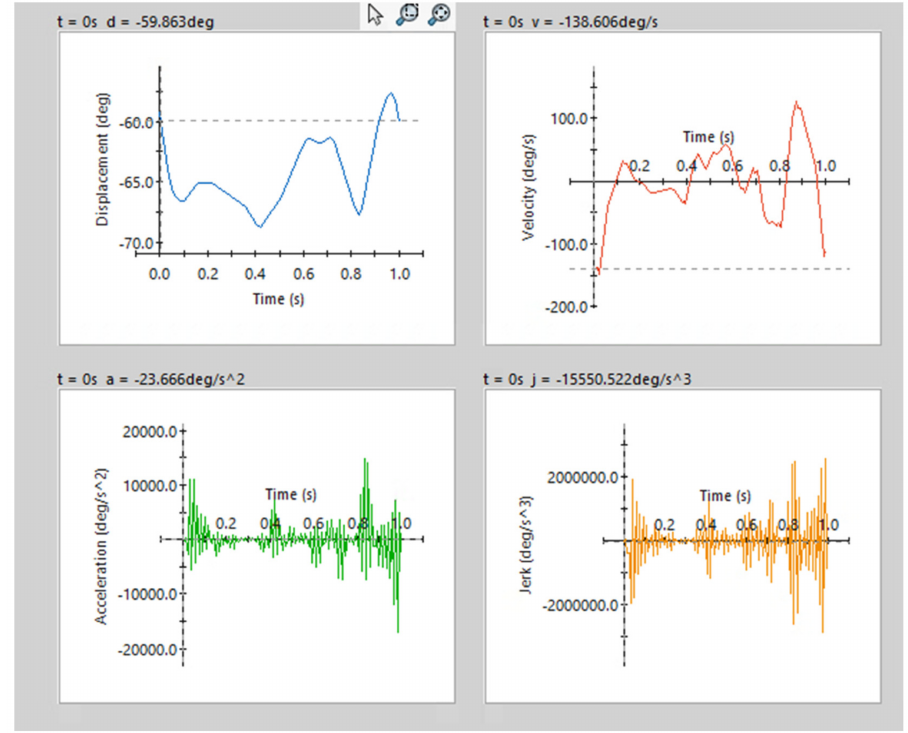
Figure 5. SolidWorks function builder used for angular displacement of the knee for crouch gait 1.